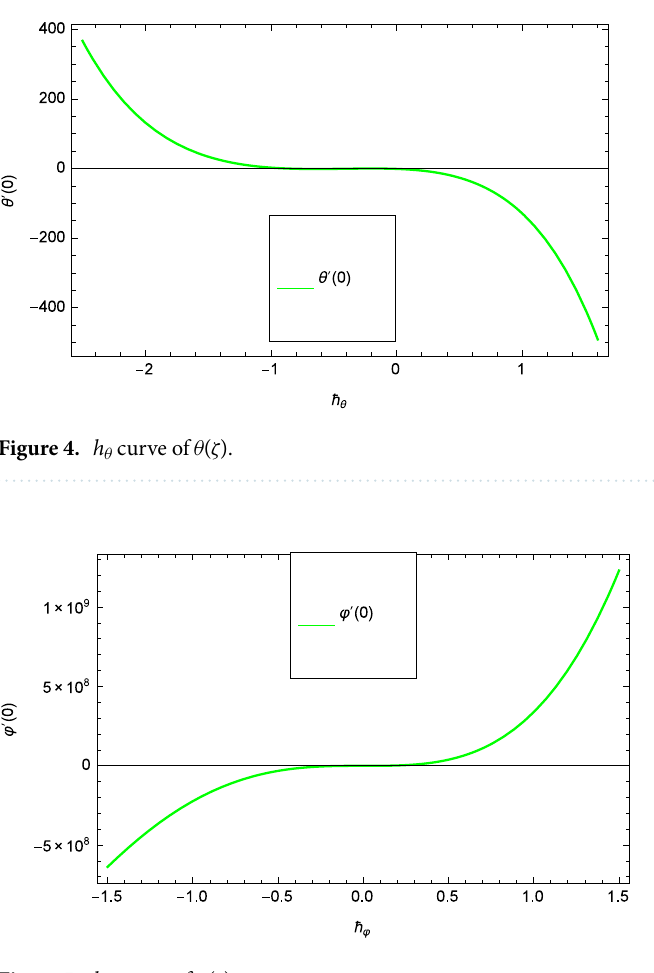
Figure 5. h ϕ curve of ϕ ( ζ ).